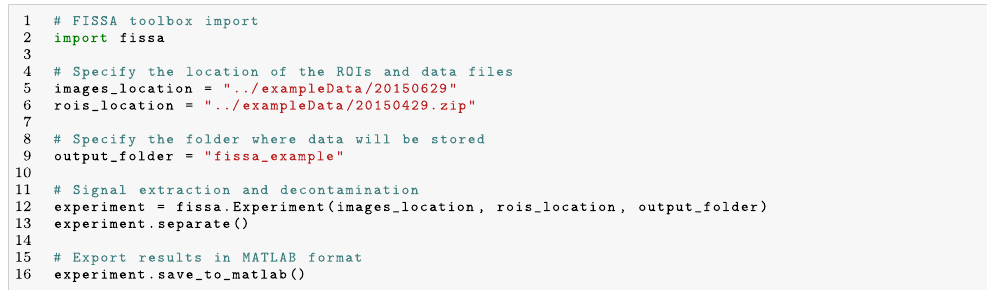
modulation index (LMI) 4 , which calculates the normalized difference between the mean change in fluorescence ( Δ f / f 0 ) during locomotion ( R L ) and stationary ( R s ) periods, as = Our results show that before neuropil decontamination almost all cells in this dataset displayed positive LMI (Fig. 5, median LMI 0.29), indicating an increase of activity during locomotion. However, after neuropil decon- tamination by any of the three methods, LMI values strongly decreased (median LMI was 0.16, 0.04, and 0.09 using neuropil subtraction, cNMF, and FISSA, respectively). These results are in agreement with previous electro- physiological experiments which reported that 20–50% of neurons with visual responses are positively modulated by locomotion in mouse V1 28,30 . The LMI values obtained with FISSA were not significantly different from those obtained with cNMF ( p = 0.0687). However, in this dataset, the subtraction method led to significantly higher LMI values than those obtained after FISSA and cNMF ( p = 0.0117).